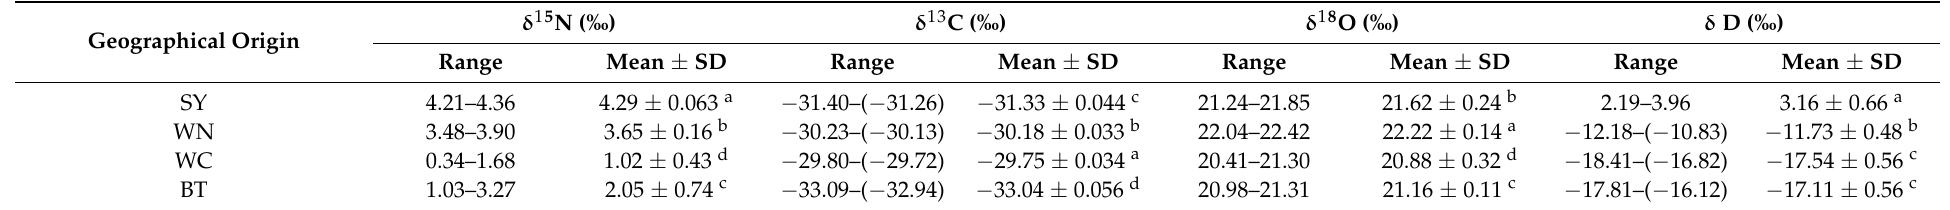
Table 1. The δ 13 C, δ 15 N, δ 18 O, and δ D values of Hainan partridge tea samples from four origins (SY, WN, WC, and BT). Superscripts on different letters indicate significant differences between